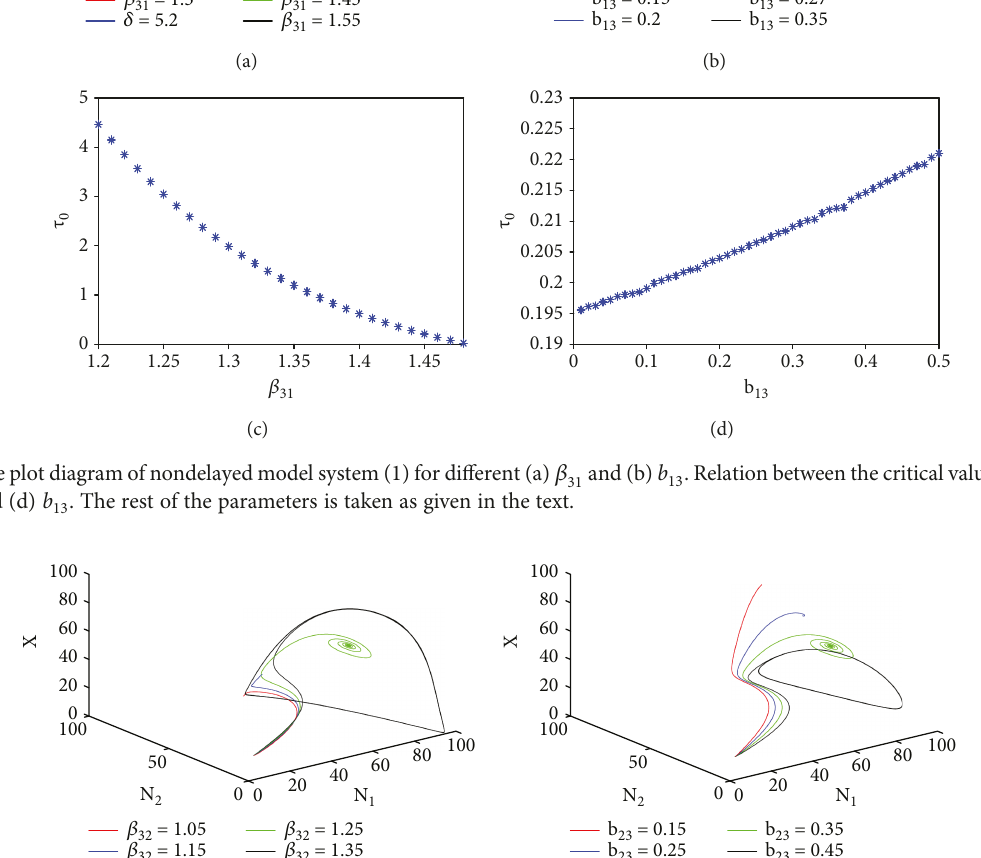
Figure 7: Phase plot diagram of nondelayed model system (1) for di ff erent (a) β the text.